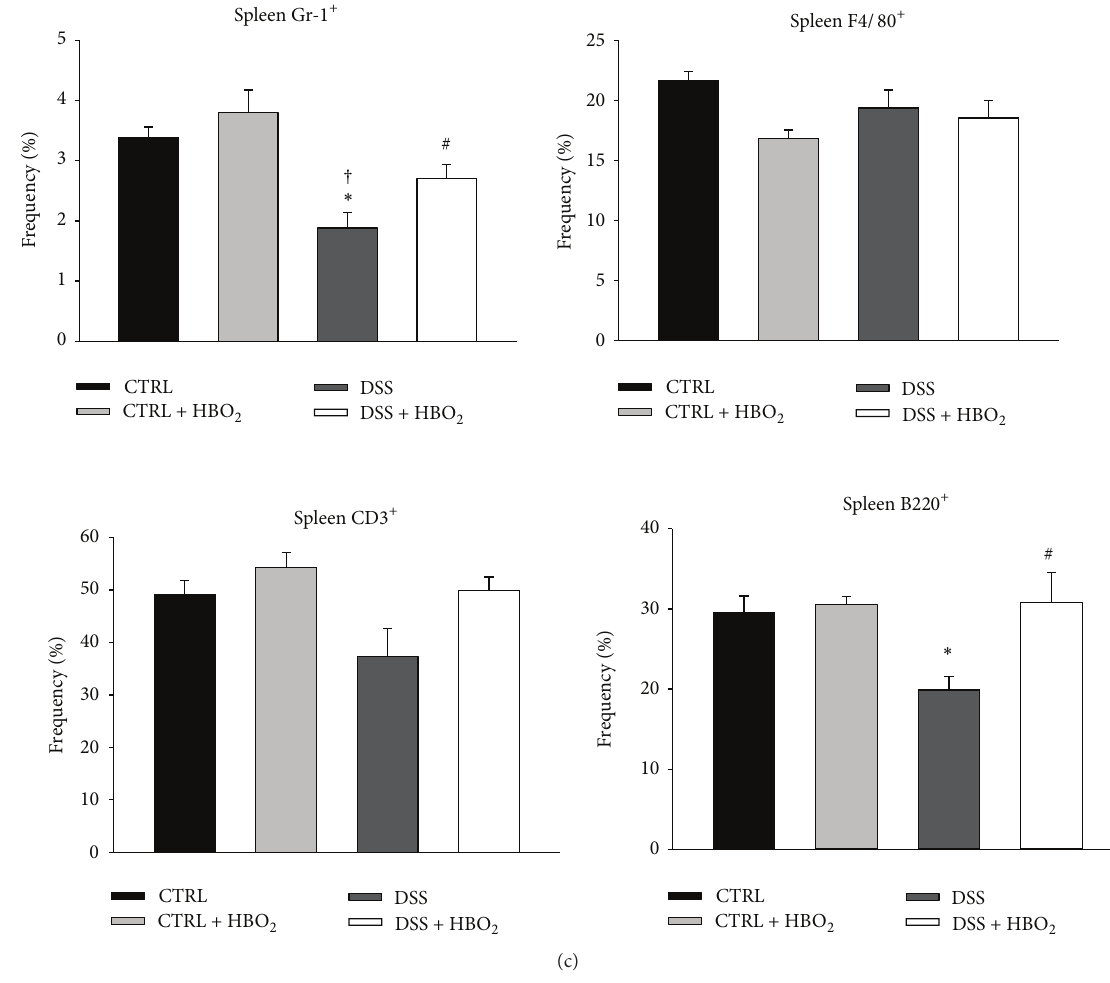
Figure 2: HBO 2 changes immune cell frequencies in the mesenteric lymph nodes (MLN) and the spleen of BALB/c mice with DSS induced colitis. BALB/c mice at the age of 10–12 weeks were randomly assigned into 4 groups ( 𝑛 = min. 5 mice/group/experiment): CTRL: control mice, CTRL + HBO 2 : control mice undergoing HBO 2 (60min/2.4 ATM, 2x/day, days 1–8), DSS: mice receiving dextran sodium sulphate (DSS, 5% w/v, days 1–7), and DSS + HBO 2 : DSS treated mice undergoing HBO 2 . Representative dot plots of MLN obtained by flow cytometry, illustrating the gating strategy for CD45 + Gr-1 + and CD45 + F4/80 + cells in MLN of CTRL, DSS, and DSS + HBO 2 groups. Doublets were excluded by forward scatter area (FSC-A) versus forward scatter height (FSC-H) and the dead cells using 7-AAD. (a) Frequency of CD45 + Gr-1 + cells, CD45 + F4/80 + cells, CD3 + T cells, and B220 + B cells in MLN (b) and spleen (c). Data are presented as mean ± s.e.m.% of single, live leukocytes (for Gr-1 + and F4/80 + cells) or single, live lymphocytes (for CD3 + and B220 + cells). ∗ Statistically different from CTRL, 𝑃 < 0.05 ; † statistically different from CTRL + HBO 𝑃 < 0.05 ; # statistically different from DSS, 𝑃 < 0.05 . 7-AAD, 7-aminoactinomycin D. 2 , the DSS + HBO 2 mice compared to the CTRL group ( 𝑃 =